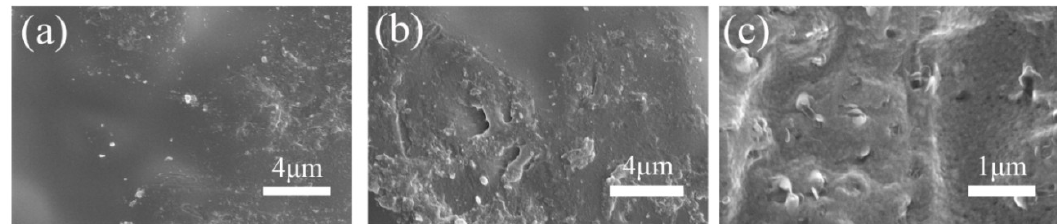
Figure 2. SEM images of ( a ) the chitosan (CS) membrane surface; and ( b ) SPES/HS-50% surface and ( c ) SPES/HS-50% cross-sections.